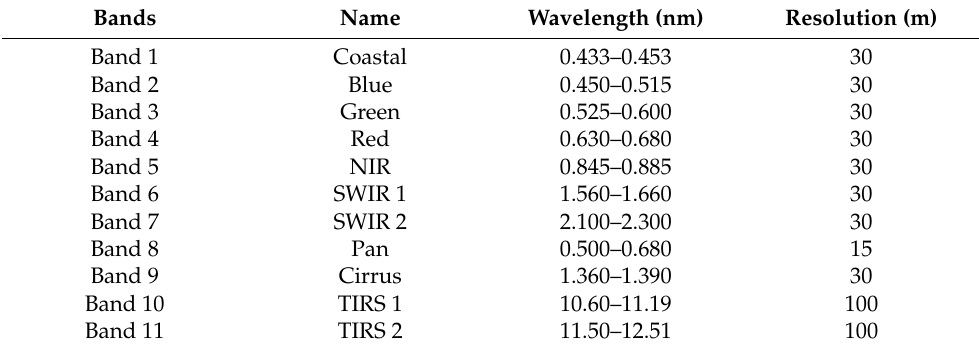
Table 1. Landsat-8 band parameters.